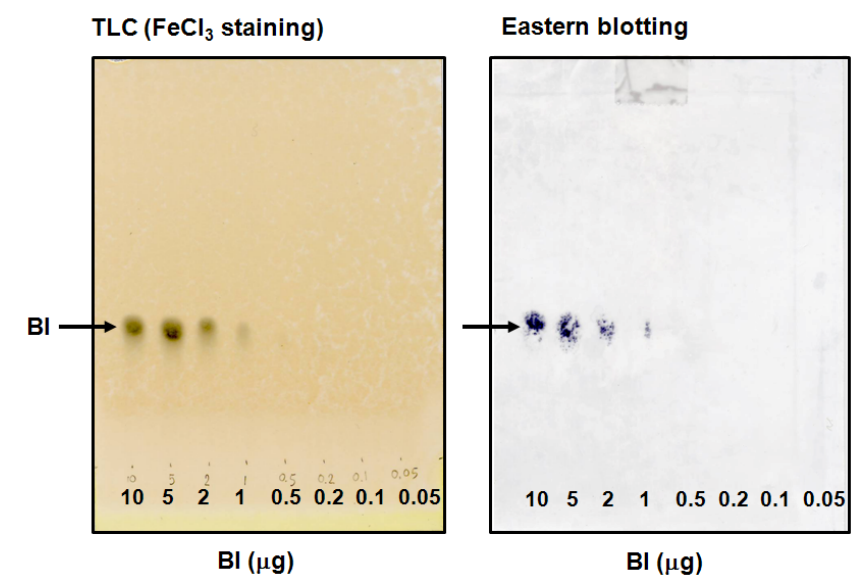
Figure 5. Eastern blotting of BI and its detection